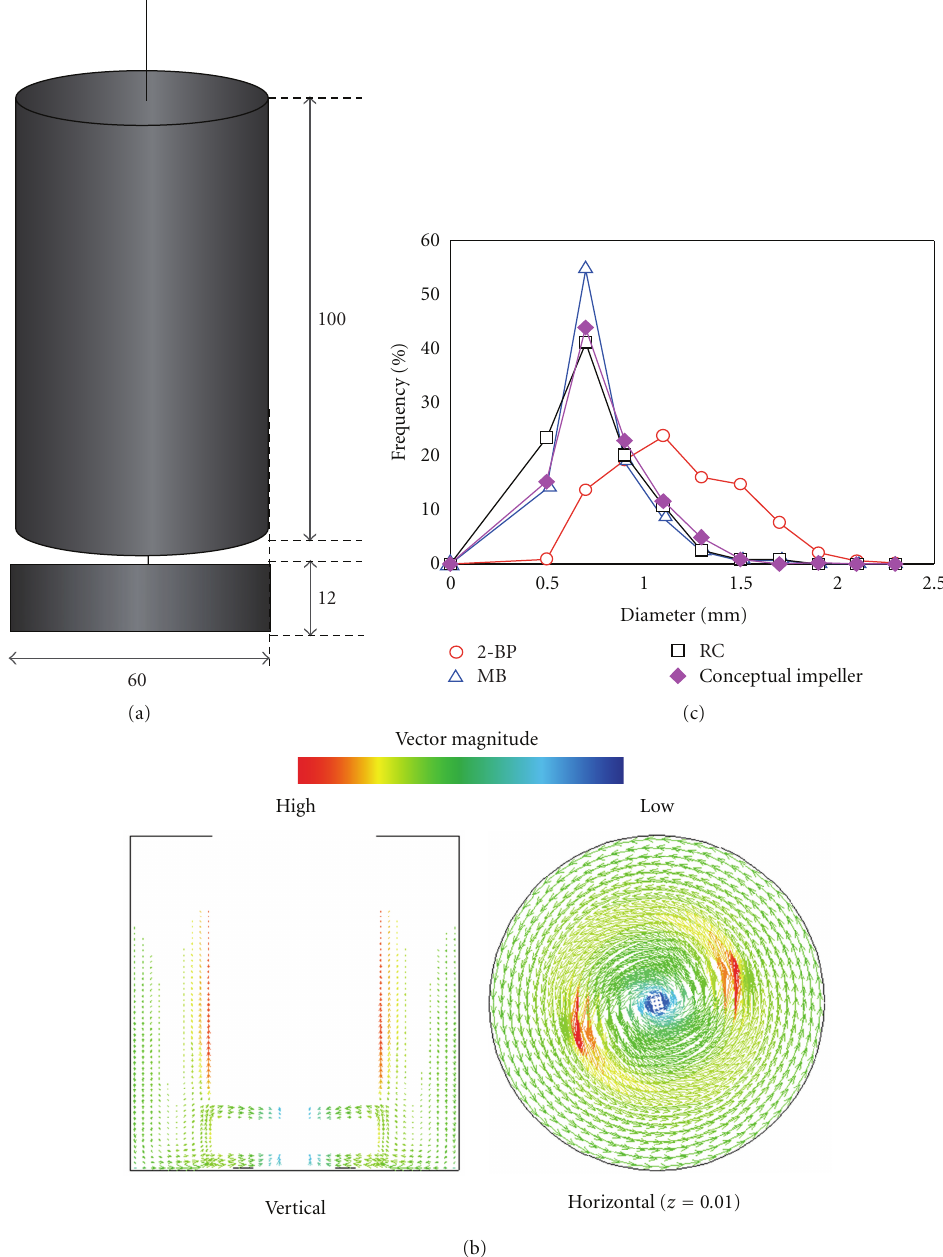
Figure 7: The summary of conceptual impeller for e ffi cient preparation of TBAB hydrate slurries; (a) schematic illustration of impeller (the unit of length is mm), (b) flow velocity-vector patterns ( n r = 300rpm), (c) particle diameter and its distribution ( n r = 300